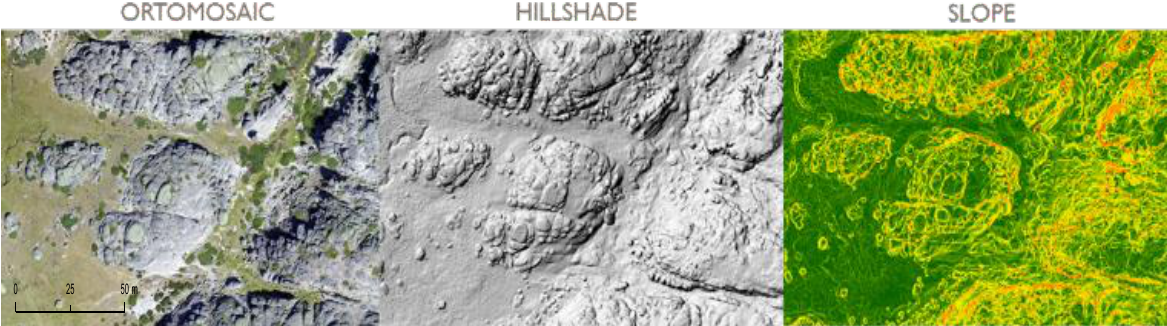
Figure 3. Models used to support the geosite analysis: orthomosaic, shadow and slope. Example from the Covão do Boi geosite.